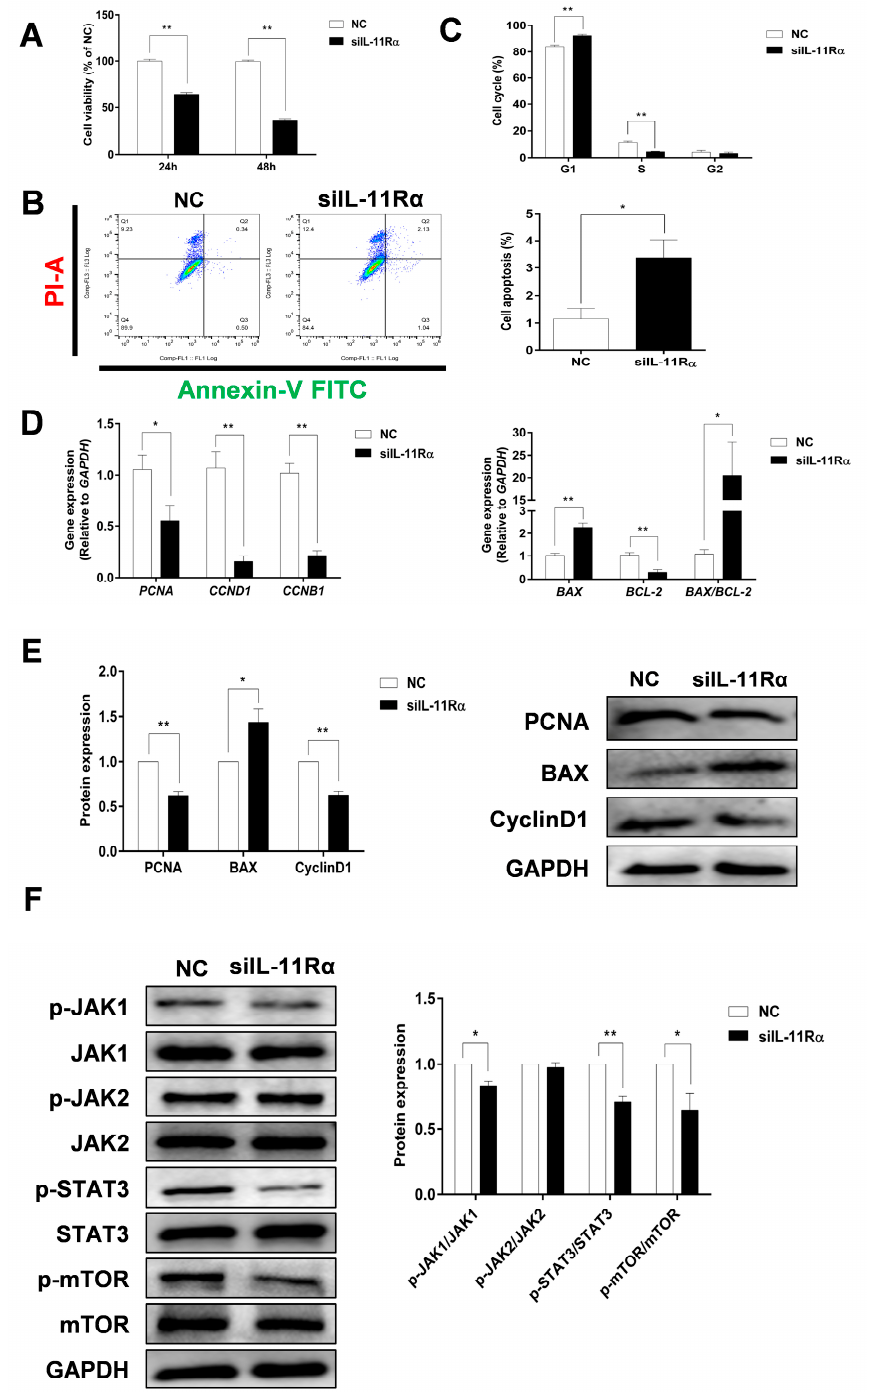
Figure 5. The effect of IL-11R α knockdown on cell proliferation and apoptosis by bovine GCs. ( A ) After siIL-11R α transfection for 24 and 48 h, cell viability was determined using the CCK-8 method and the cell viability of the control group was set at 100%, data represent two independent experi- ments, each completed in triplicate. ( B,C ) After siIL-11R α transfection for 48 h, cell apoptosis was